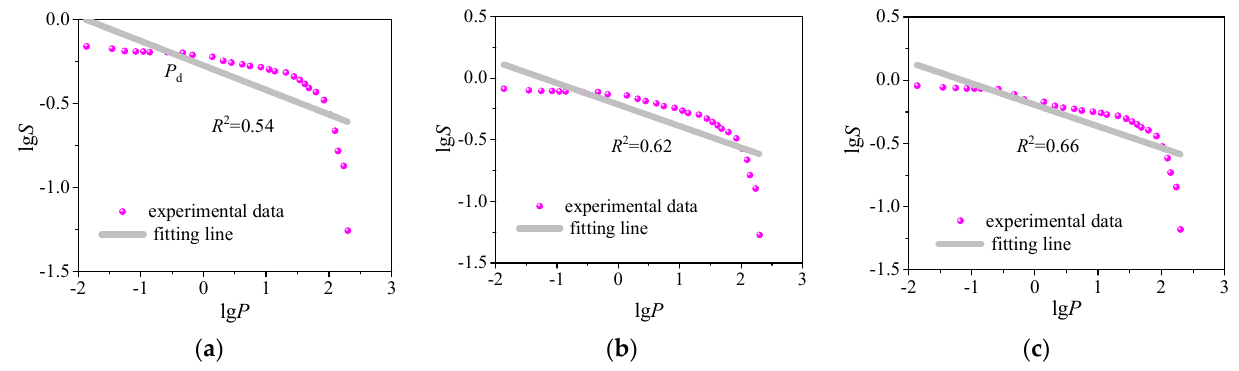
Figure 4. Log–log fitting results for the entire pore size range, based on MIP. ( a ) M1, ( b ) M2, and ( c )